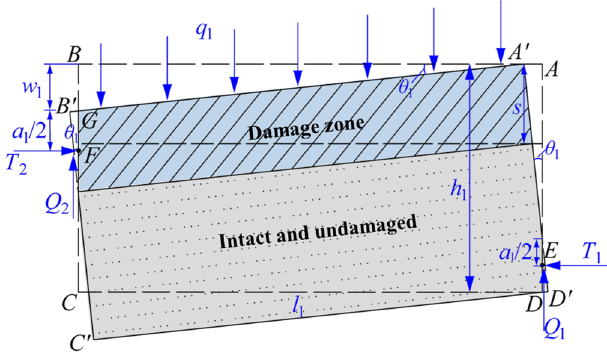
Figure 6. Stress of key block of the damaged main roof.